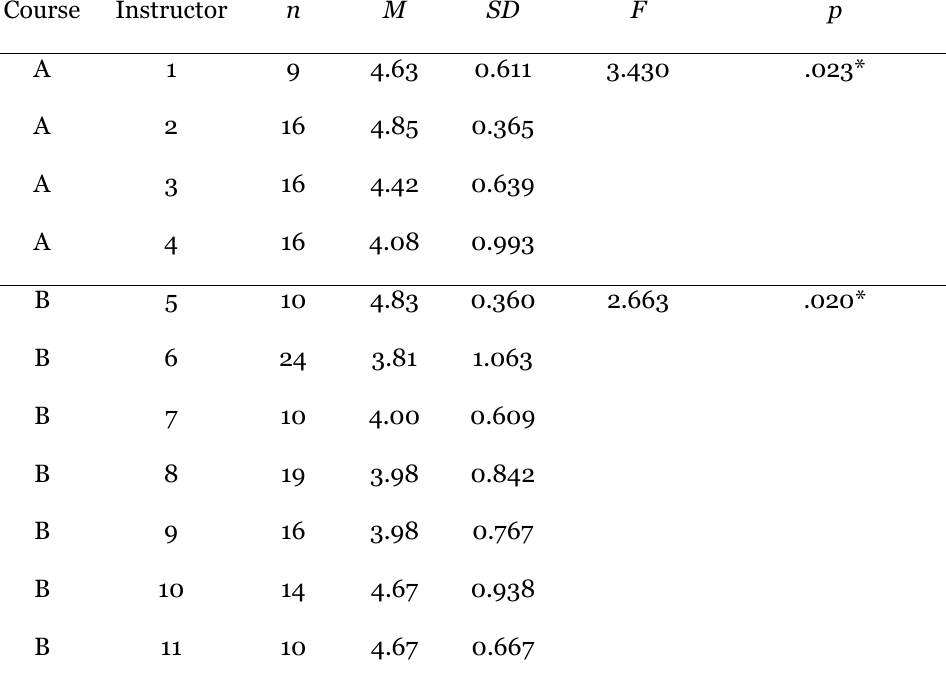
Descriptive Statistics of Direct Instruction (DI) Scores as a Function of Instructor and Course